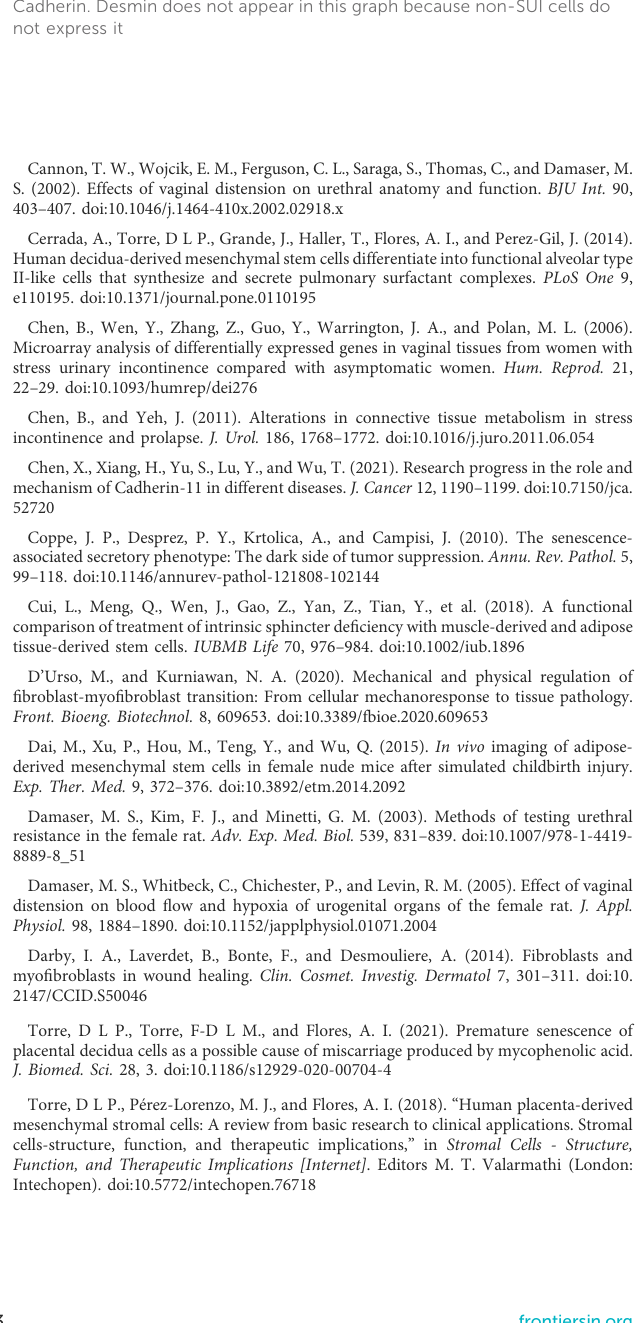
SUPPLEMENTARY FIGURE S1 Gene expression of myo fi broblast markers in suburethral fi broblasts cultures of gynecological patients without incontinence (non-SUI). Gene expression of myo fi broblast markers was determined by real-time qPCR in suburethral fi broblasts isolated from patients without incontinence. The analyzed cells correspond to passage 3 (n=2 or 4). Data are presented as mean ± standard deviation (SD). Gene abbreviations are as follow: α -SMA, alpha smooth muscle actin; Vim, vimentin; Des, desmin; Smooth, smoothelin; Ten, tenascin; Col, collagen I, PDPN, podoplanin; Cad, Cadherin. Desmin does not appear in this graph because non-SUI cells